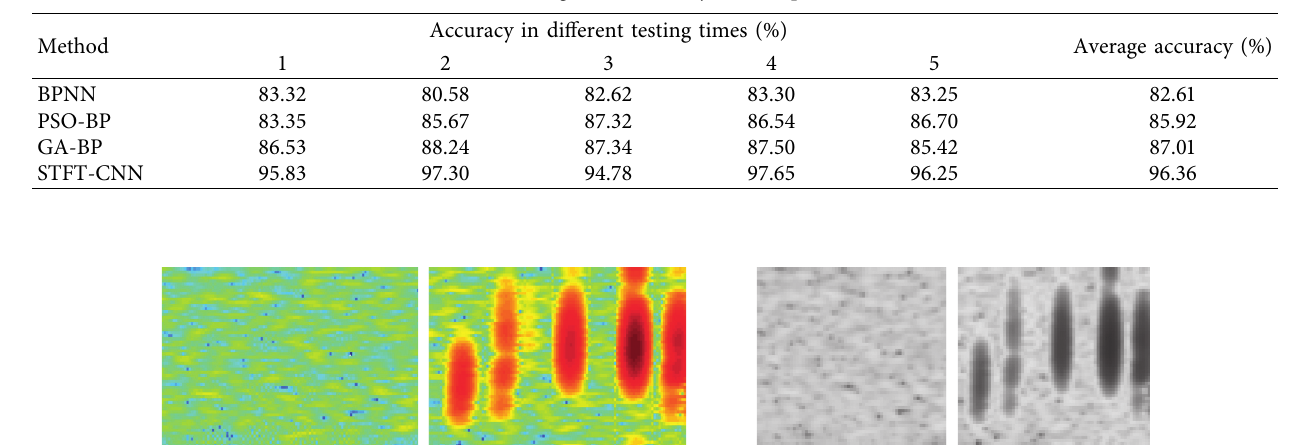
Table 4: Diagnostic accuracy of multiple tests.